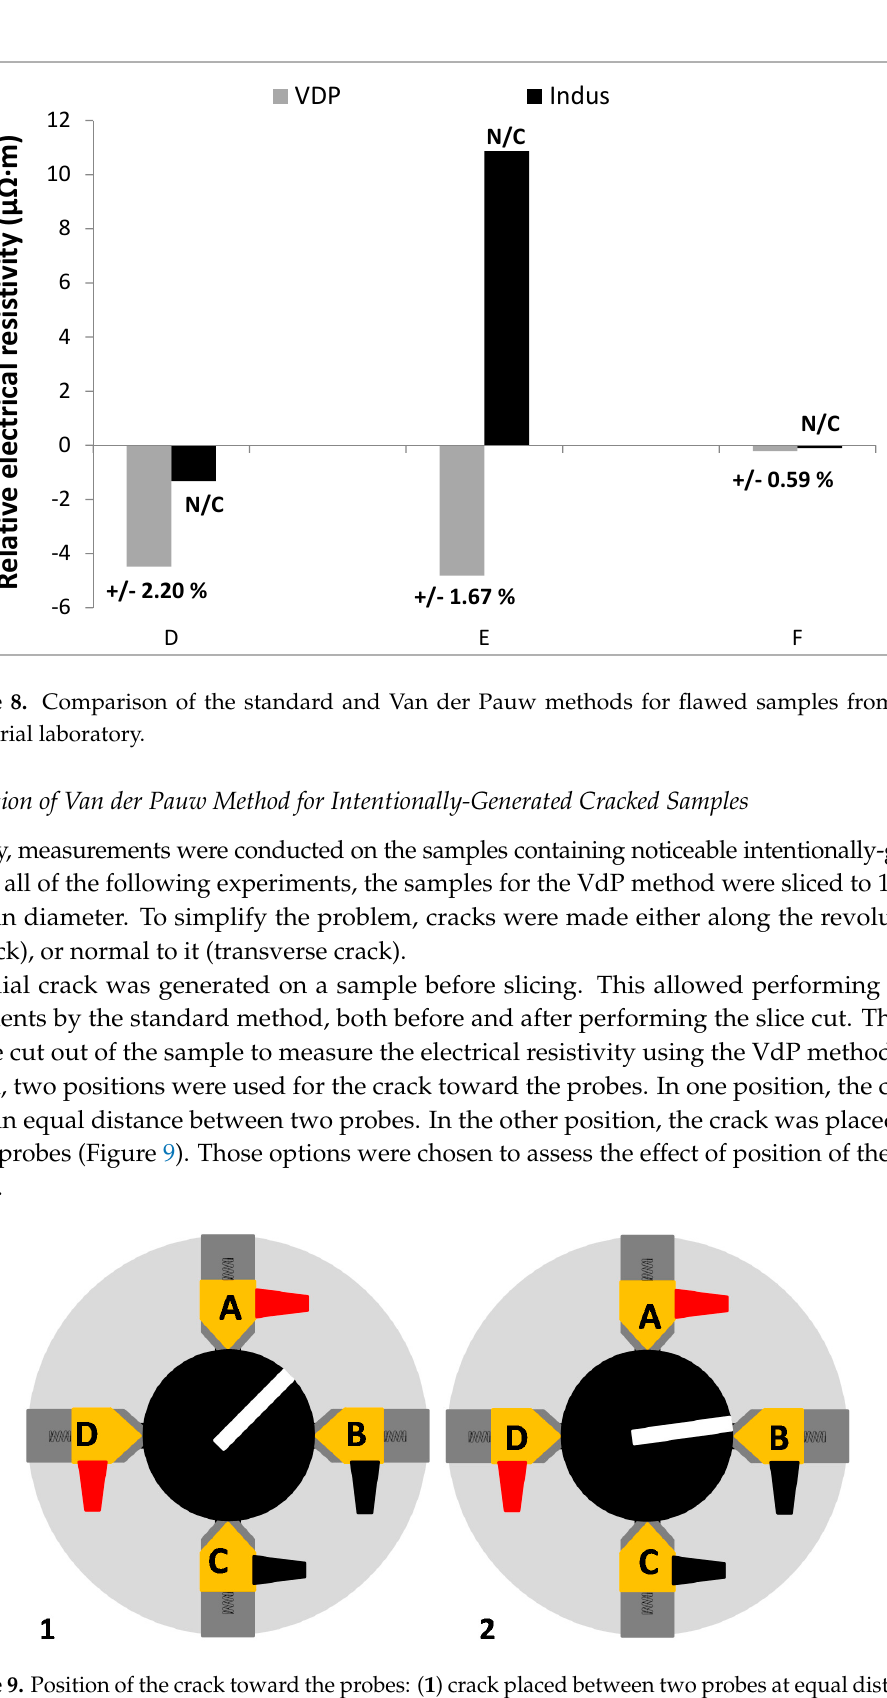
Figure 9. Position of the crack toward the probes: ( 1 ) crack placed between two probes at equal distance; ( 2 ) crack placed close to one of the probes.